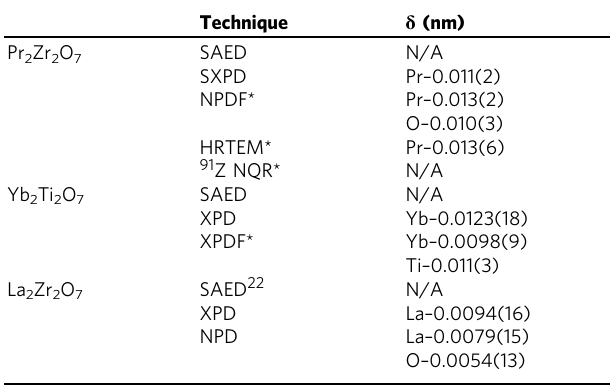
Table 1 Summary of experimental